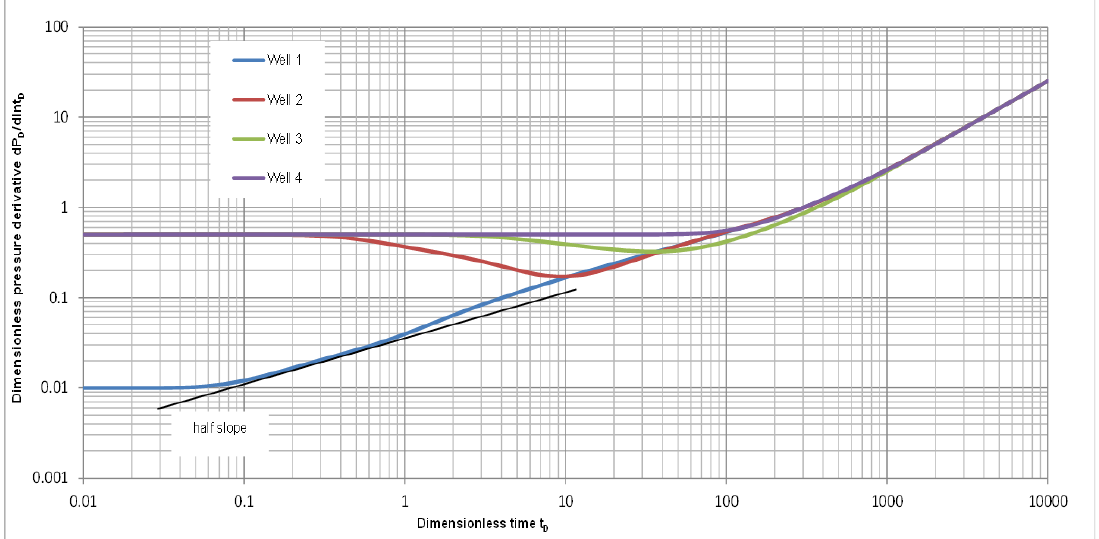
Figure 17. Pressure derivatives of the 4 wells under K 1 /K 2 =50, C S1 /C S2 =1.